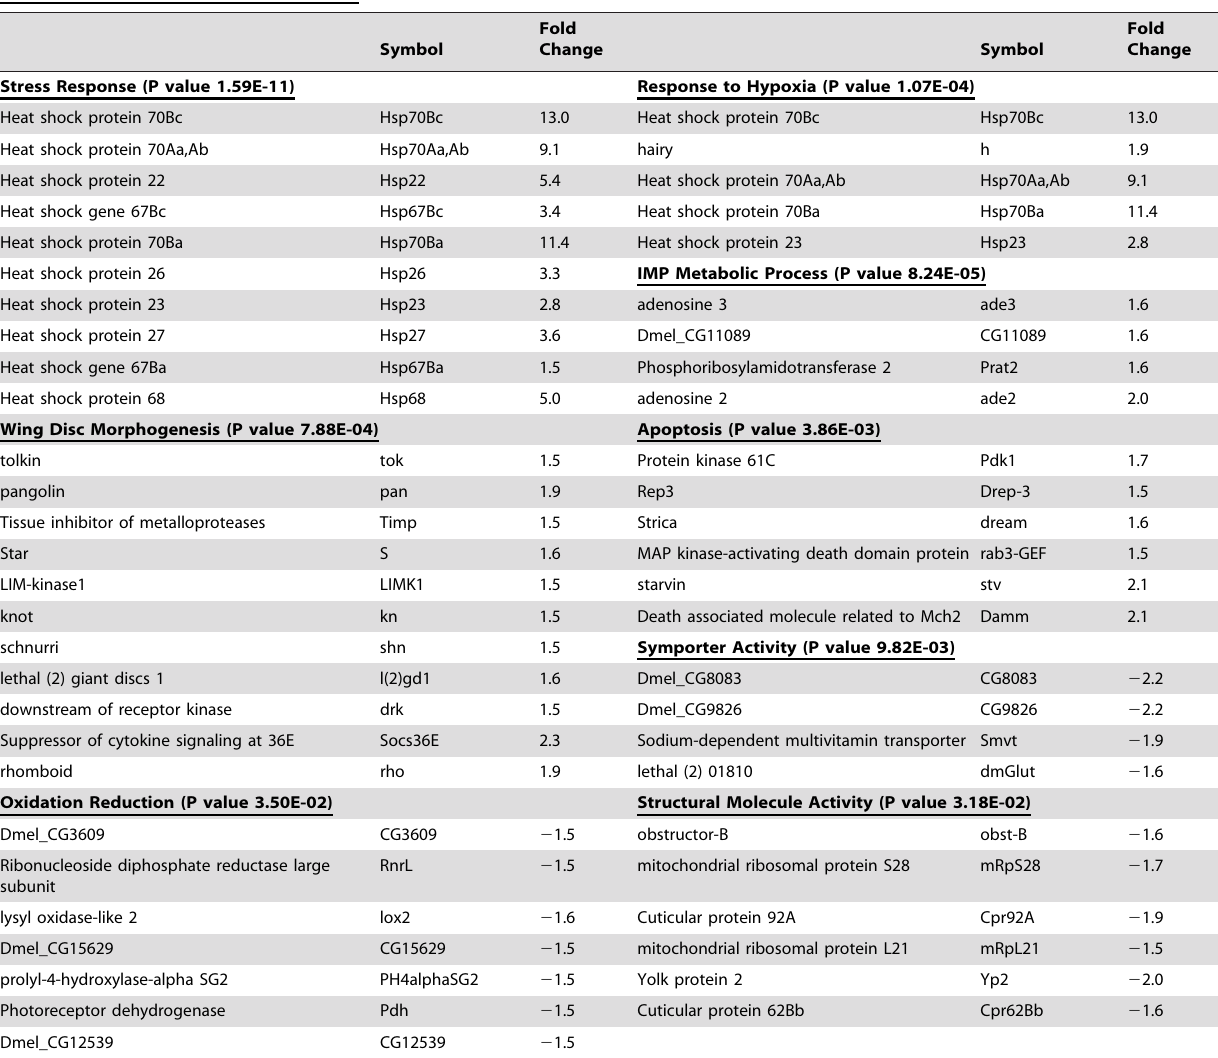
Catagories of genes with altered